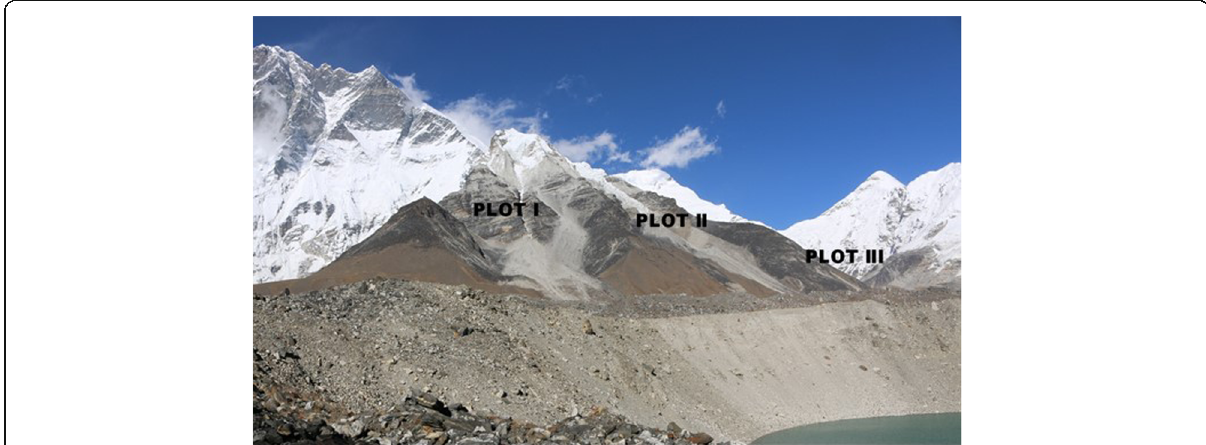
Fig. 4 Plots identified based on field